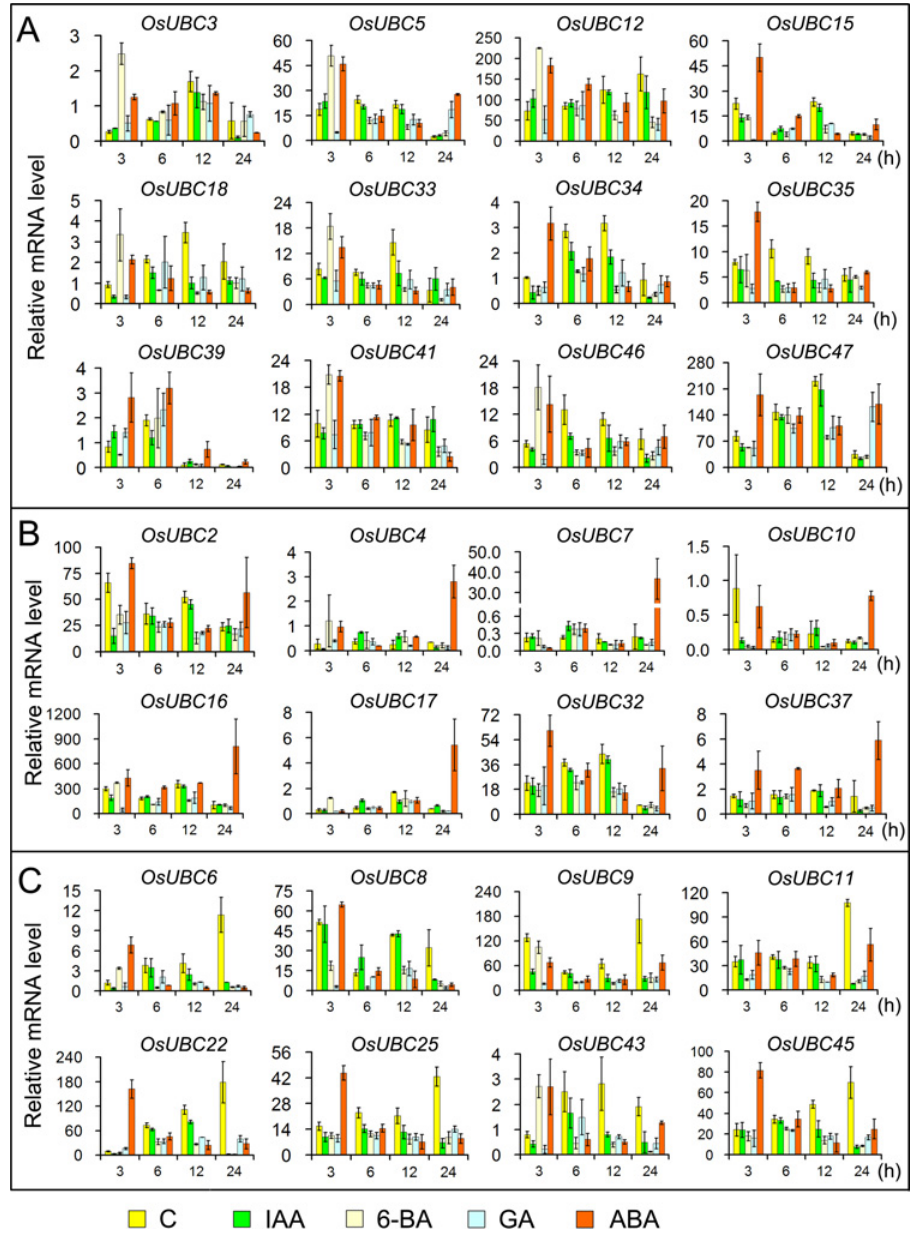
Fig 7. Expression analysis of OsUBC genes under different hormone treatments. X-axis indicates time course/treatment and Y-axes are scales of relative expression level. (A) Showing the genes up-regulated by 6-BA or ABA at 3h; (B) Showing the genes up-regulated by ABA at 24h; (C) Showing the genes down- regulated by the four hormones at 12h and 24h; Error bars indicate standard deviations of independent biological replicates (n = 3 or more). C, control; IAA , indole-3-acetic acid; 6-BA , 6-Benzylaminopurine; GA , gibberellin acid; ABA , abscisic acid; h,